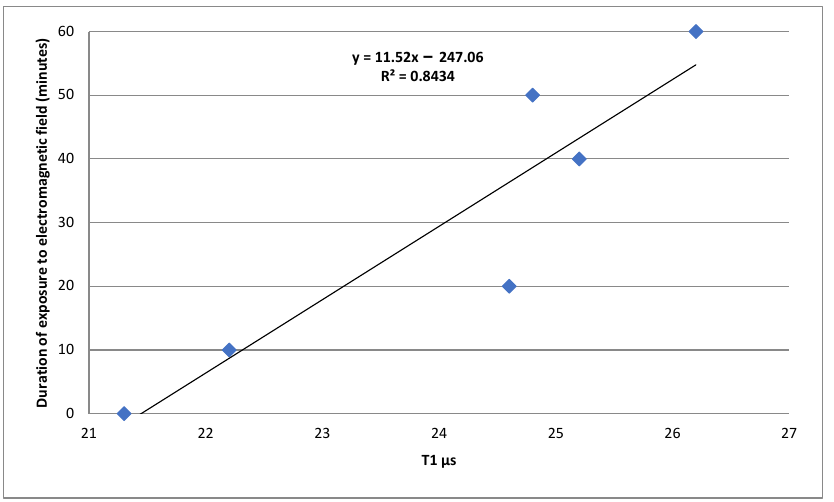
Figure 11. Electronic relation time T 1 plotted against the electromagnetic exposure time of oil.